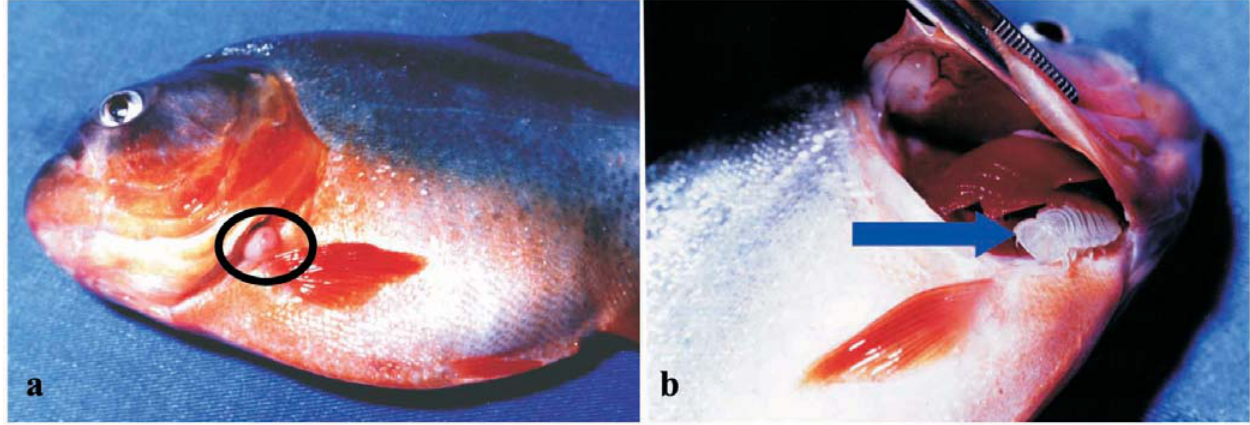
Fig. 2. The circle outlines a tumor (a) observed on Pygocentrus nattereri , possibly caused by the action of the isopod Braga patagonica (b).